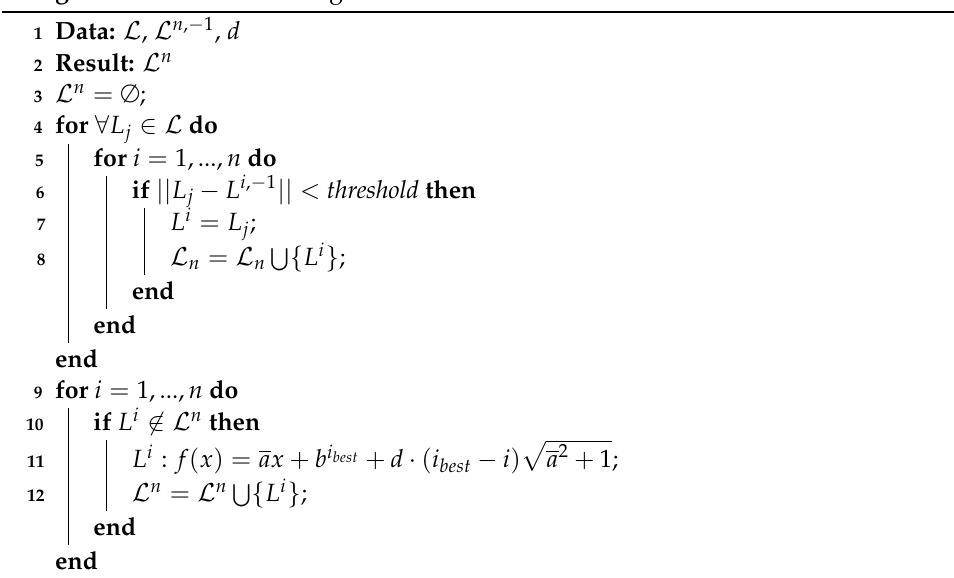
Algorithm 4: Model filtering.